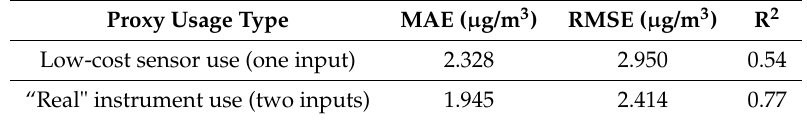
Table 4. The performance metrics of the Bayesian WB proxy using one and two types of